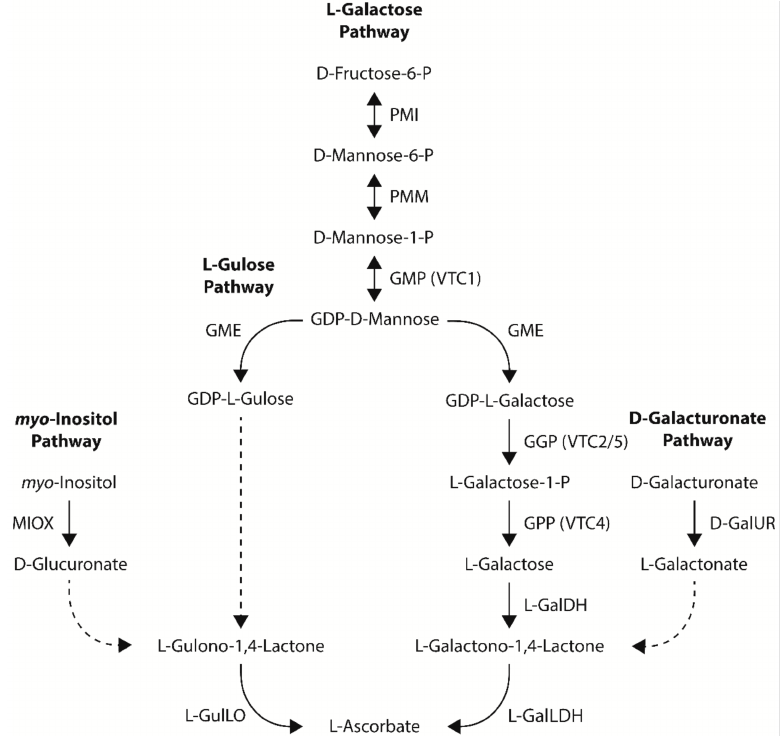
Figure 2. The four proposed ascorbate biosynthetic pathways in higher plants—the L-galactose, L-gulose, myo -inositol, and D-galacturonate pathways. Dashed arrows indicate multiple and / or unknown biosynthetic steps in higher plants. PMI, phosphomannose isomerase; PMM, phosphomannose mutase; GMP, GDP-D-mannose pyrophosphorylase; GME, GDP-D-mannose-3 (cid:48) ,5 (cid:48) -epimerase; GGP, GDP-L-galactose phosphorylase; GPP, L-galactose-1-P phosphatase; L-GalDH, L-galactose dehydrogenase; L-GalLDH, L-GalLDH L-galactono-1,4-lactone dehydrogenase; L-GulLO, L-gulono-1,4-lactone oxidase; MIOX, myo -inositol oxygenase; D-GalUR, D-galacturonate